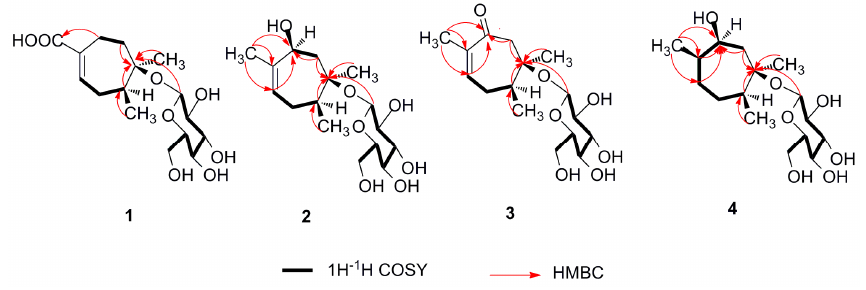
Figure 2. Key COSY and HMBC correlations of compounds 1 – 4 .